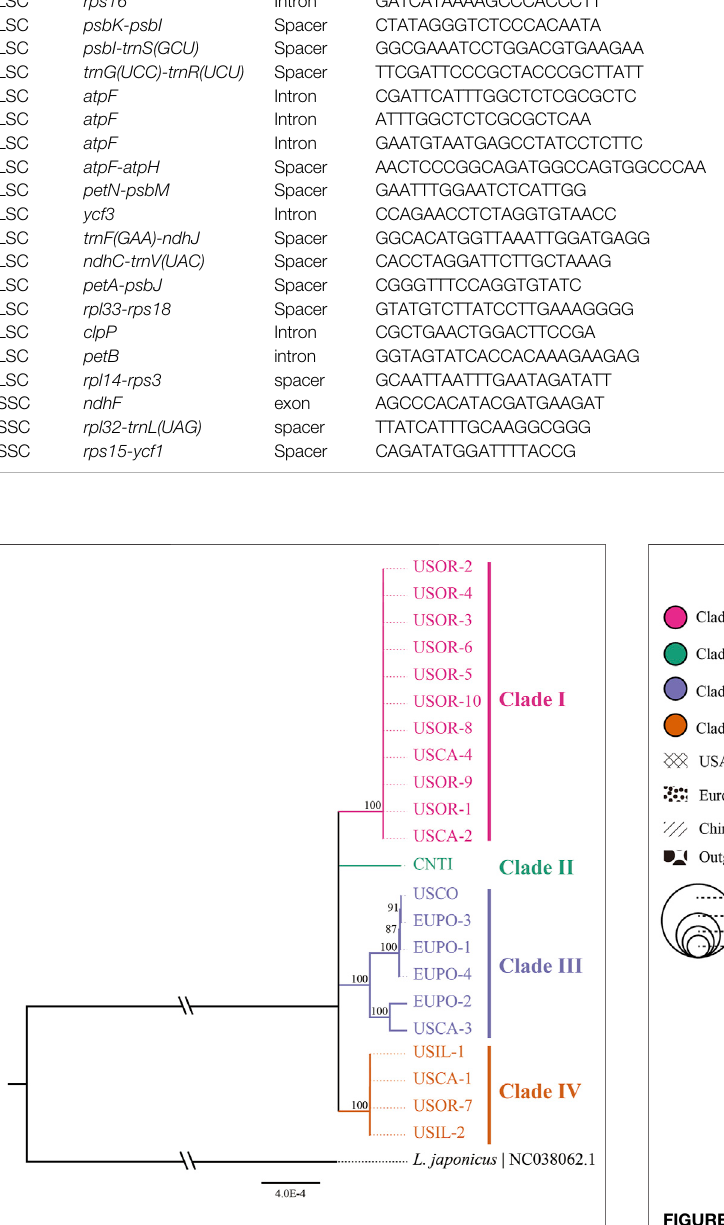
FIGURE 7 | Phylogenetic relationships among 22 L. cardiaca accessions constructed from complete chloroplast genome sequences using maximum likelihood (ML). The ML topology is shown, with the ML bootstrap support value for each node. 22 accessions cluster to four clades show by different color.